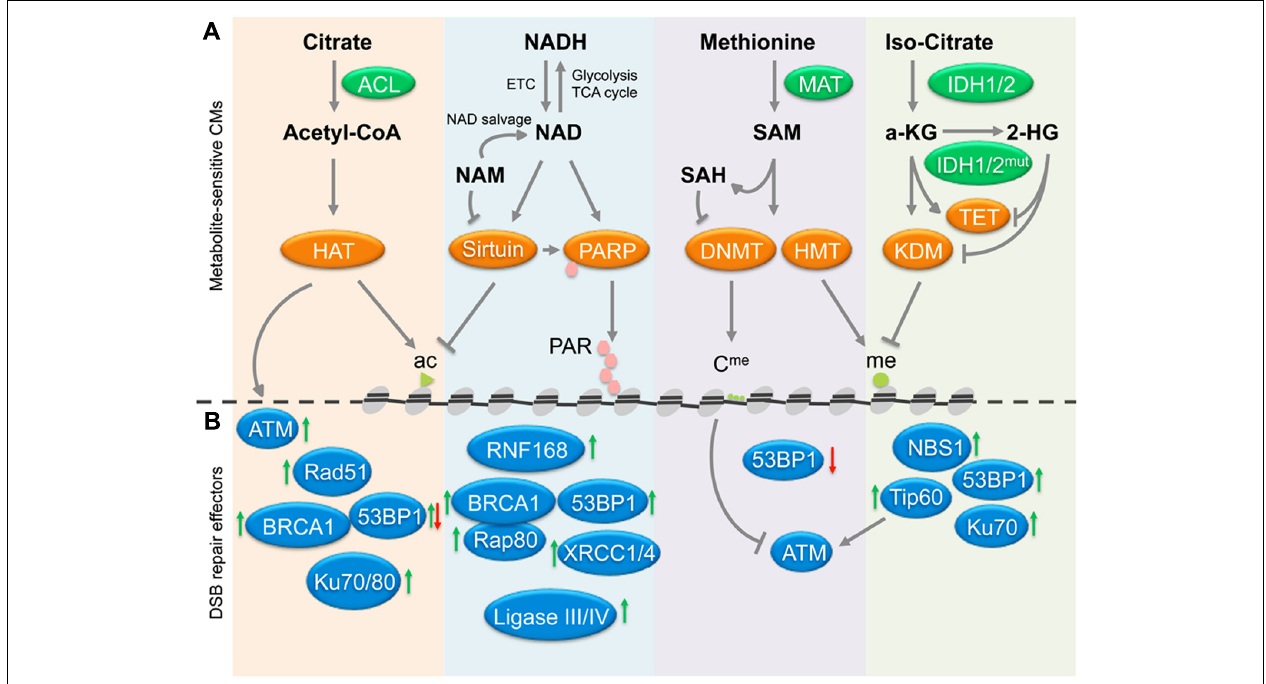
a given chromatin modification results in increased recruitment/activation of the indicated repair factors, red arrows depict impaired activation/recruitment in the presence of the same modification. See Table 1 for a detailed list of modifiers and modifications involved in DSB repair. In addition to chromatin, the HATTip60 can acetylate and activate the central DDR mediator ATM kinase (gray arrows), whereas ATM activity is negatively affected by DNA methylation (blunted gray arrow). Ac, acetylated histone; me, methylated histone; C me , methy-cytosine; PAR, poly-(ADP-ribose); ETC, electron transport chain; HAT, histone acetyl transfrease; HMT, histone methyltransferase; KDM, lysine demethylase. See text for enzyme and metabolite